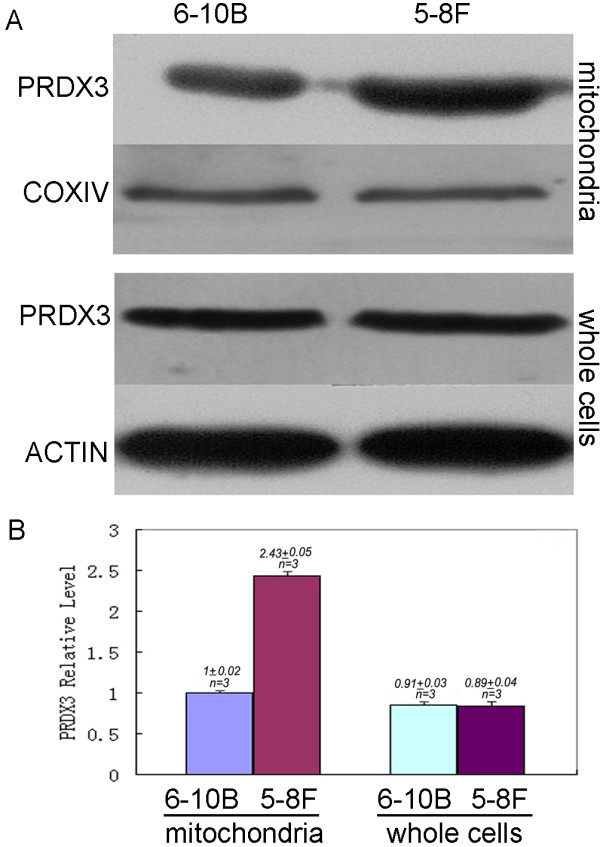
Up-regulated expressions of PRDX3 in metastatic 5-8F cell mitochondria relative to nonmetastatic 6-10B cell mitochondria without significant expression difference in the level of whole cells.A. Western blotting image. B. The quantitative comparison of the digitized Western blotting image. COXIV, a marker protein of mitochondria, was used as a reference standard protein when mitochondrial protein sample was analyzed with Western blot. ACTIN that is mainly expressed in the cytoplasm was used a reference standard protein when whole-cell protein sample was analyzed with Western blot. Western blot experiments were carried out triply (n = 3).